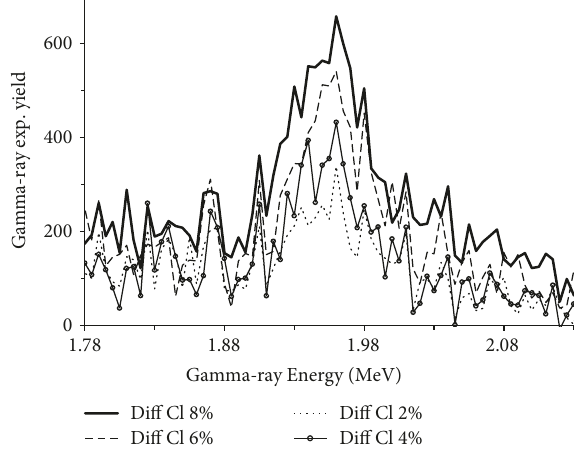
Figure 12: Pulse height di ff erence spectra of the CeBr 1951 – 1959 keV chlorine gamma rays from 2%, 4%, 6%, and 8% chlorine-contaminated water samples over 1.78 – 2.13MeV range superimposed upon each